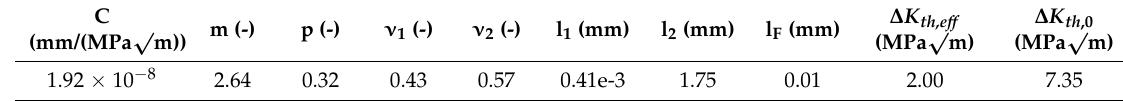
Table 3. Parameters of applied modified NASGRO model for steel